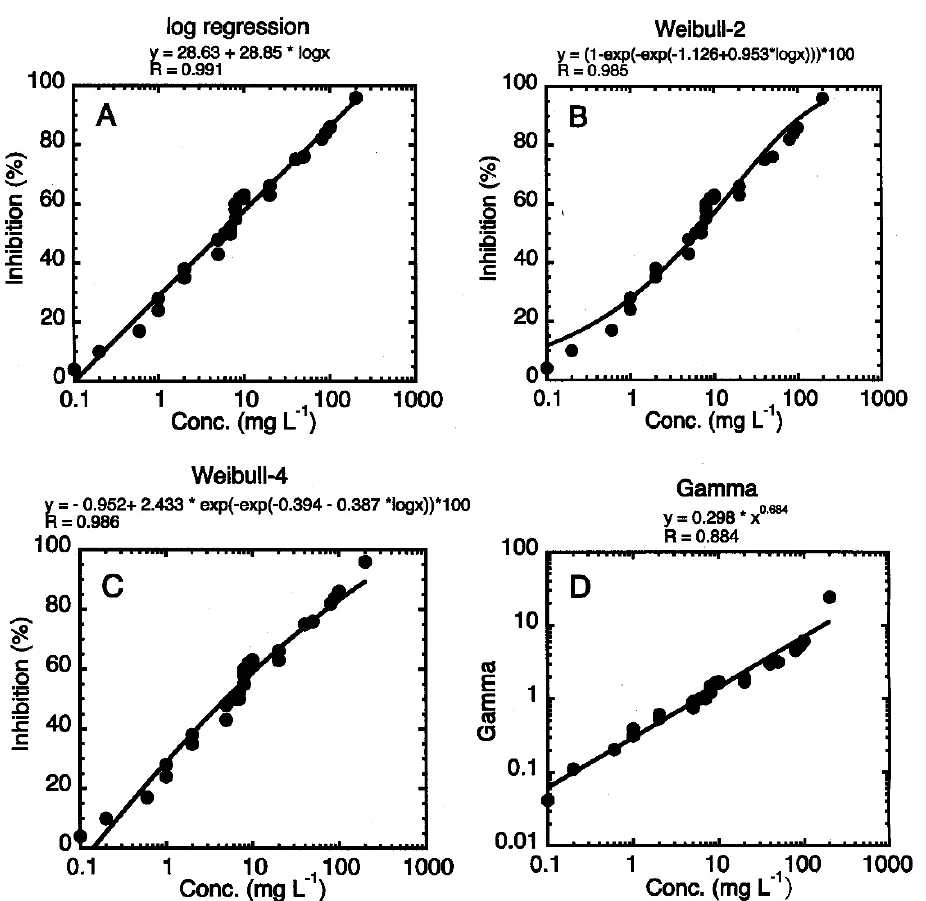
Figure 7. Toxicity data obtained with 2.3-dichlorophenol (27 h incubation time) were analyzed by four different statistical fit procedures: ( A ) log-regression fit, ( B ) two-parameter Weibull fit, ( C ) four-parameter Weibull fit and ( D ) gamma fit.